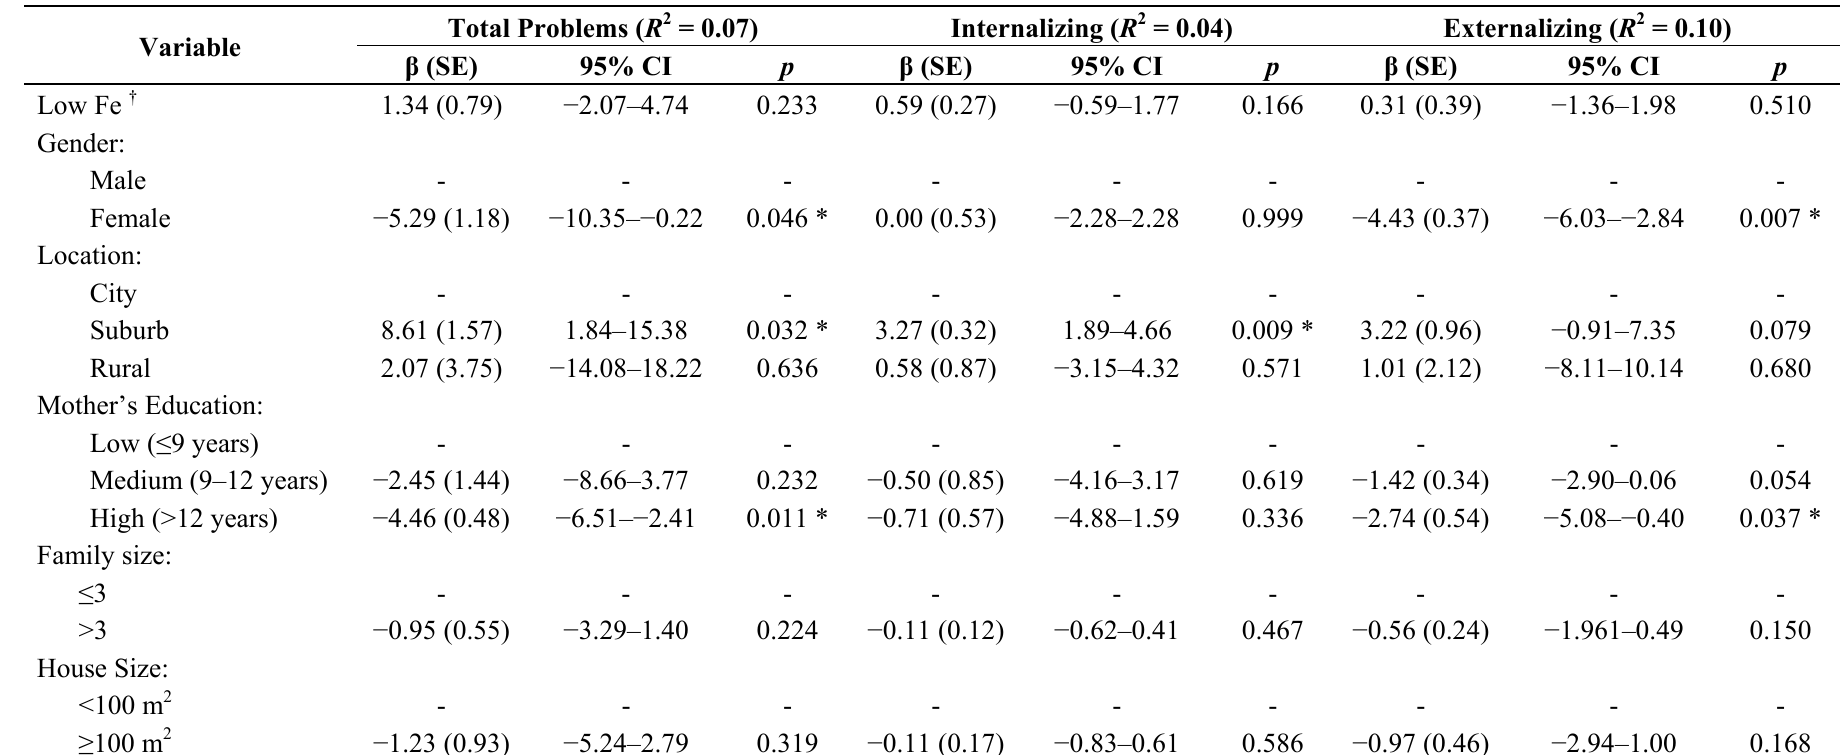
Table 6. The effect of Iron on children’s behavior problems ( N =